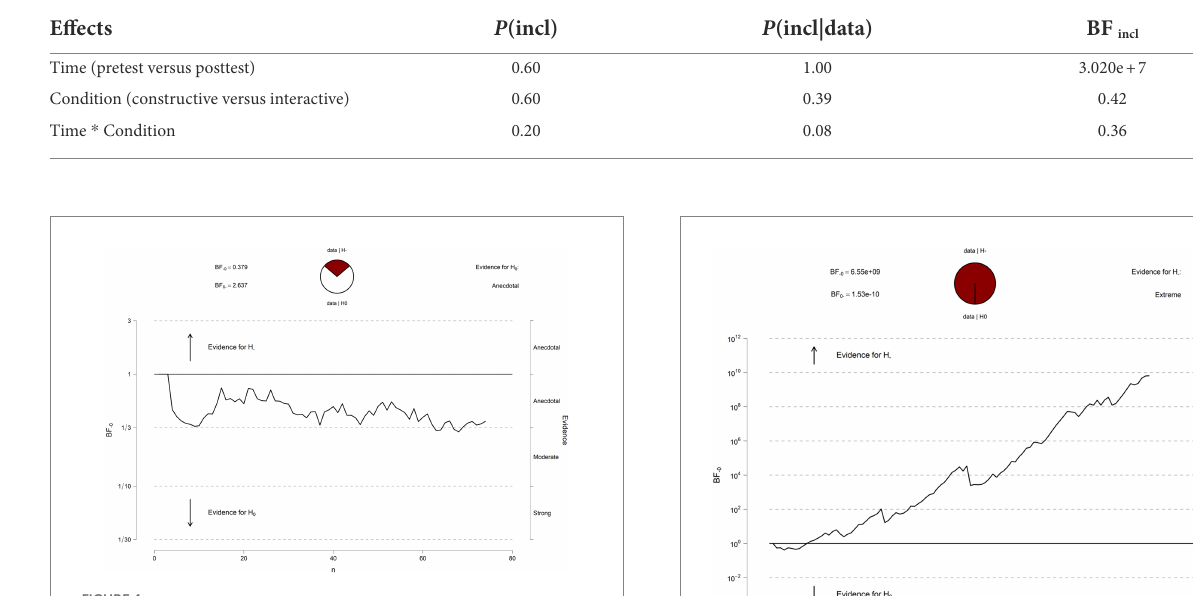
FIGURE 4 Results of the sequential analysis for the effect of the condition on skill.